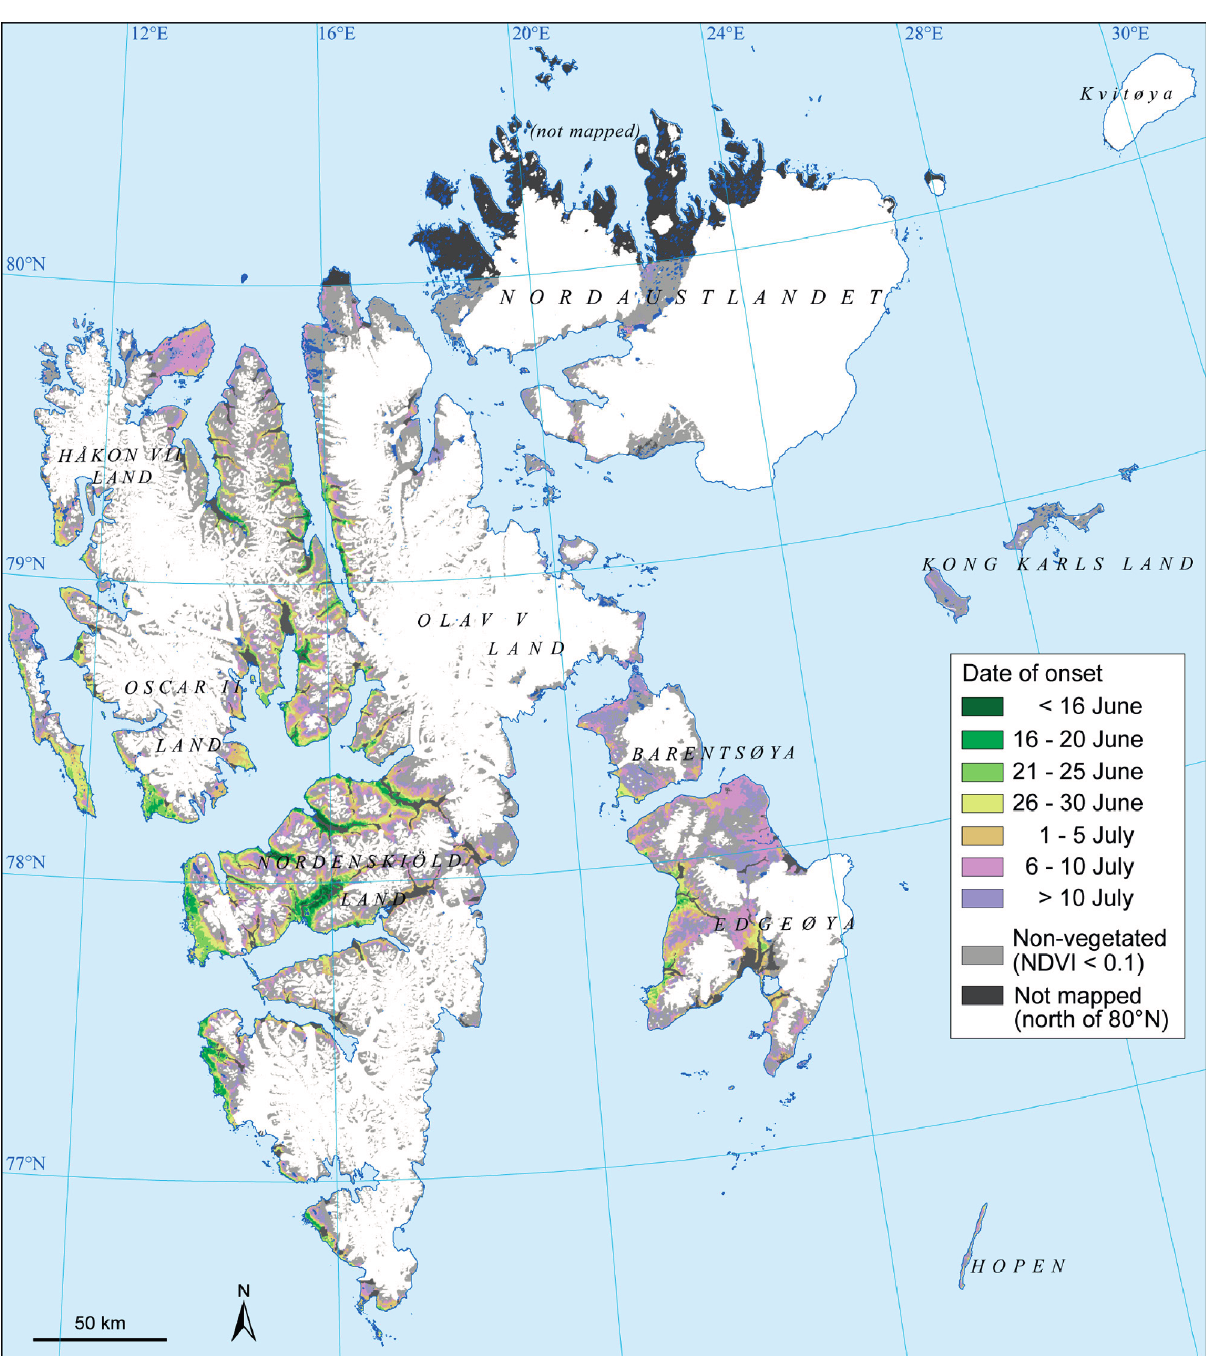
Figure 5. Time of onset of the growing season, based on mean values from the MODIS-NDVI dataset for the period